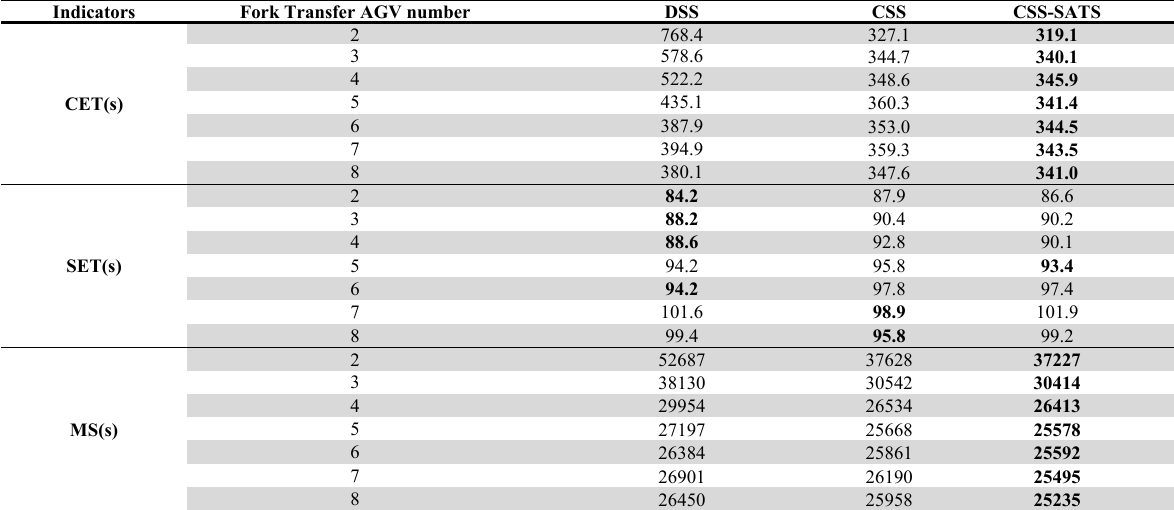
Results of experiment B (The bold is the best value among three algorithms) (Continued) Indicators